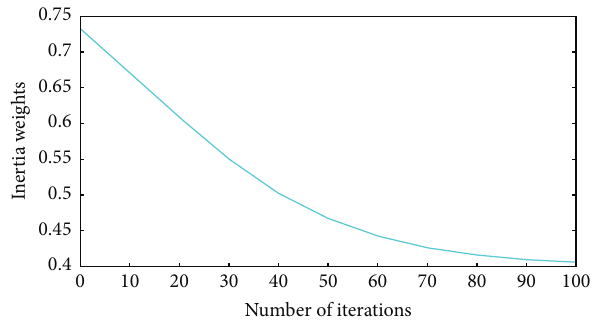
Figure 3: The curve of inertia weight in PSO.